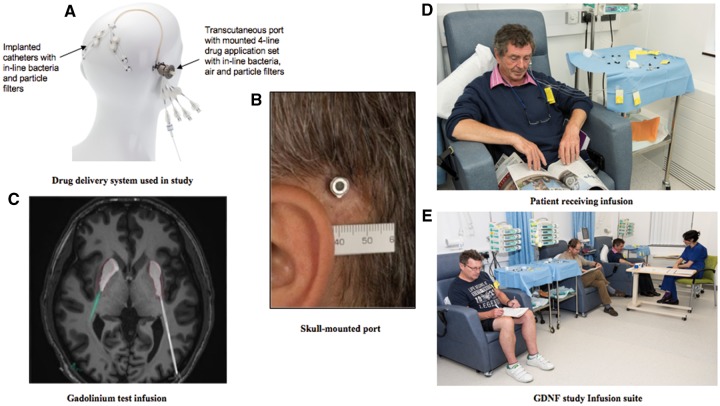

Method of drug administration. (A) Drug delivery system used in the study. A manikin view of the delivery system is shown. Externally, when infusions are delivered, a titanium application set is attached to a skull-mounted port. The application set houses four independent external lines that feed back to four independent B. Braun pumps (not shown) for the administration of GDNF or placebo. Internally, from the skull mounted port, run four independent catheters. (B) The skull-mounted port is the only external component when the patient is not receiving an infusion. (C) Gadolinium test infusion. An axial MRI section at the level of the striatum is shown. Two of the four catheters (dorsal two catheters) can be seen entering either side of the brain posteriorly to penetrate the putamen. T1 imaging has been acquired post a test infusion of 2 mM gadolinium down the catheters and into each putamen. Gadolinium can be seen distributed through both putamen from the rostral to caudal extent. (D) A single patient during infusion. (E) Three patients receiving their monthly intraputamenal infusions from B. Braun pumps via their skull-mounted ports, in a standard day-case facility, observed by an accompanying nurse.